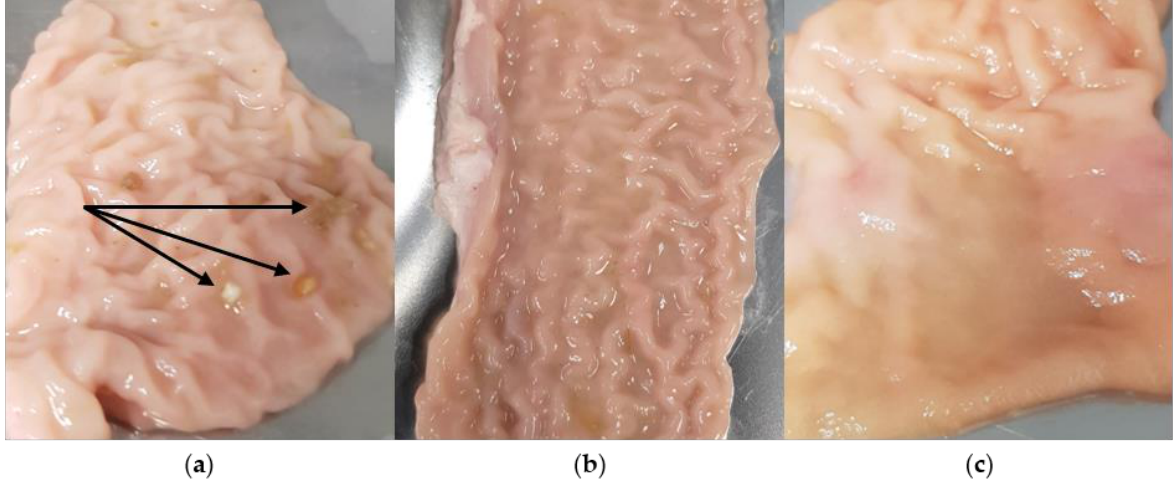
Figure 9. Differences between the individual tissue samples of the pig small intestines. ( a ) pig #1; ( b ) pig #2; ( c ) pig #3. The intestinal tube was cut longitudinally and divided into approx. 5 cm × 7 cm sections. Food components (about 3 mm) present in pig #1 are marked with arrows.